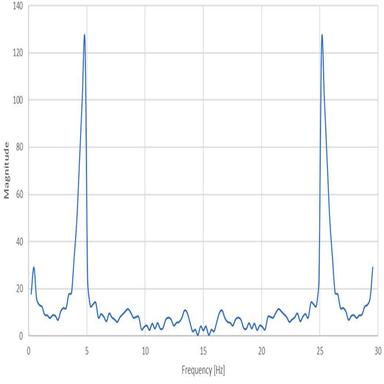
Fourier transform - free vibration response.